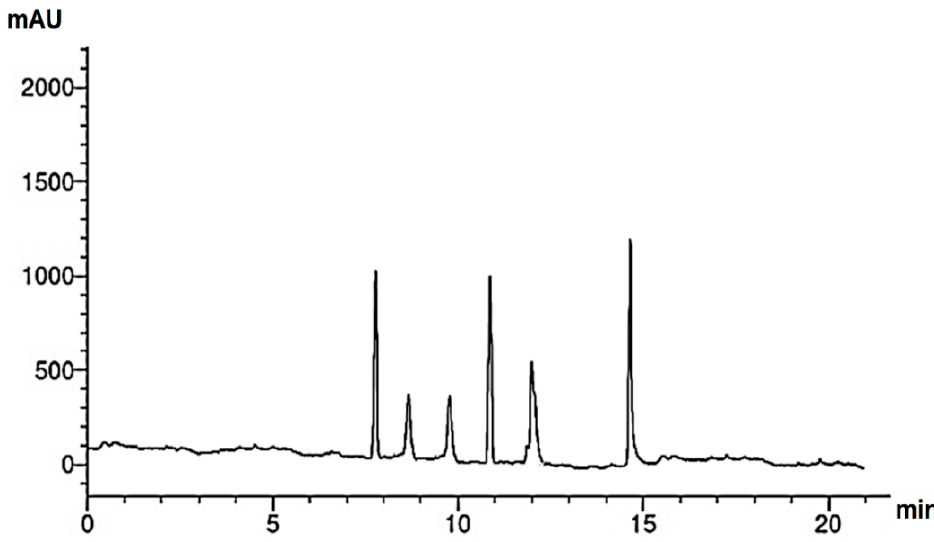
Figure 3. HPLC chromatogram of phenolic acids of M. pulegium extract.